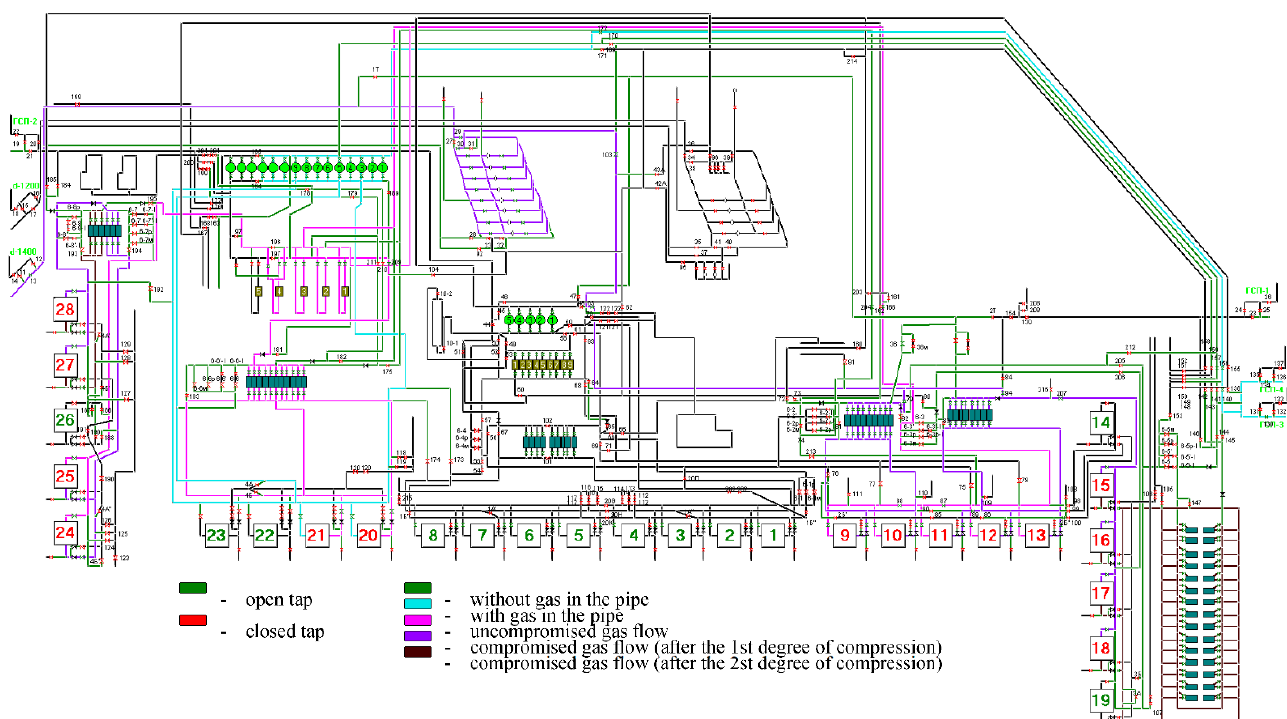
Figure 7. Piping and instrumentation diagram of the compressor station and gas treatment system.